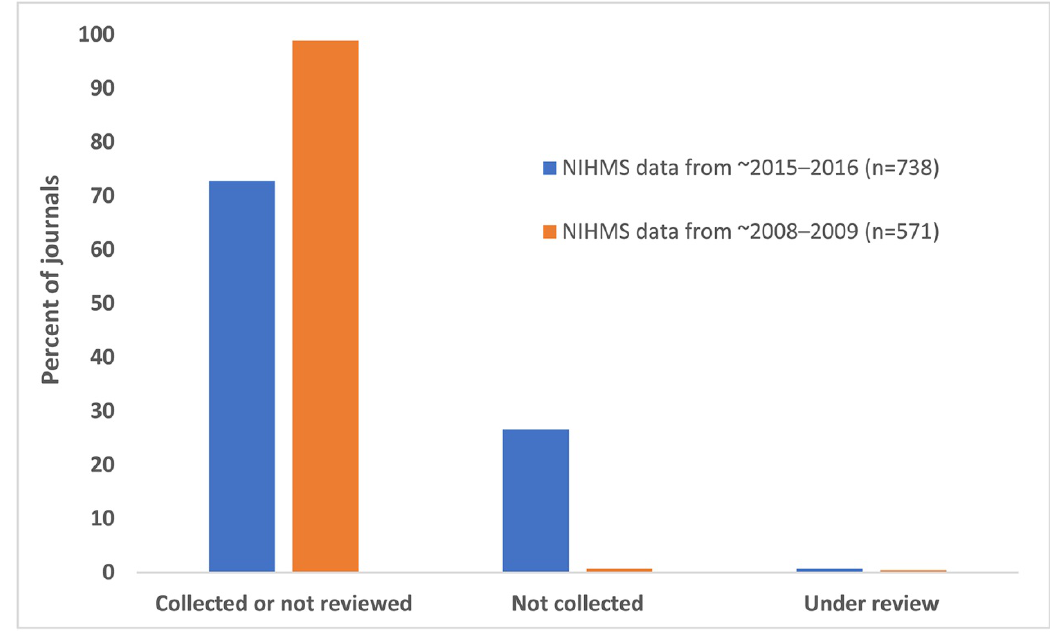
~2008–2009 NIHMS data are taken from a previously published study [4] and were reanalyzed based on current publisher